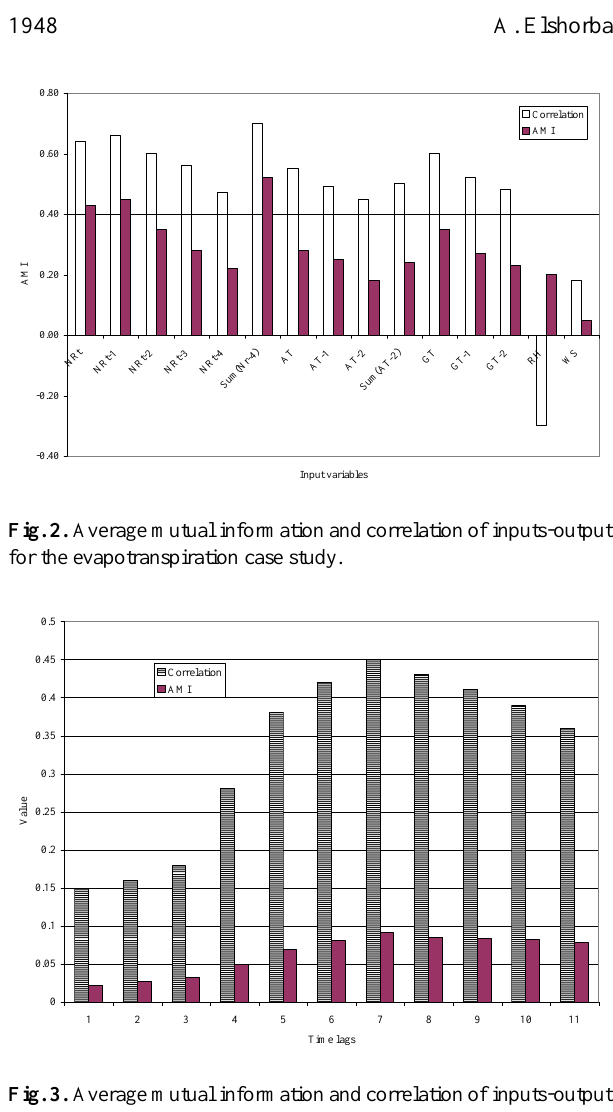
Fig. 3. Average mutual information and correlation of inputs-output for the rainfall-runoff case study.